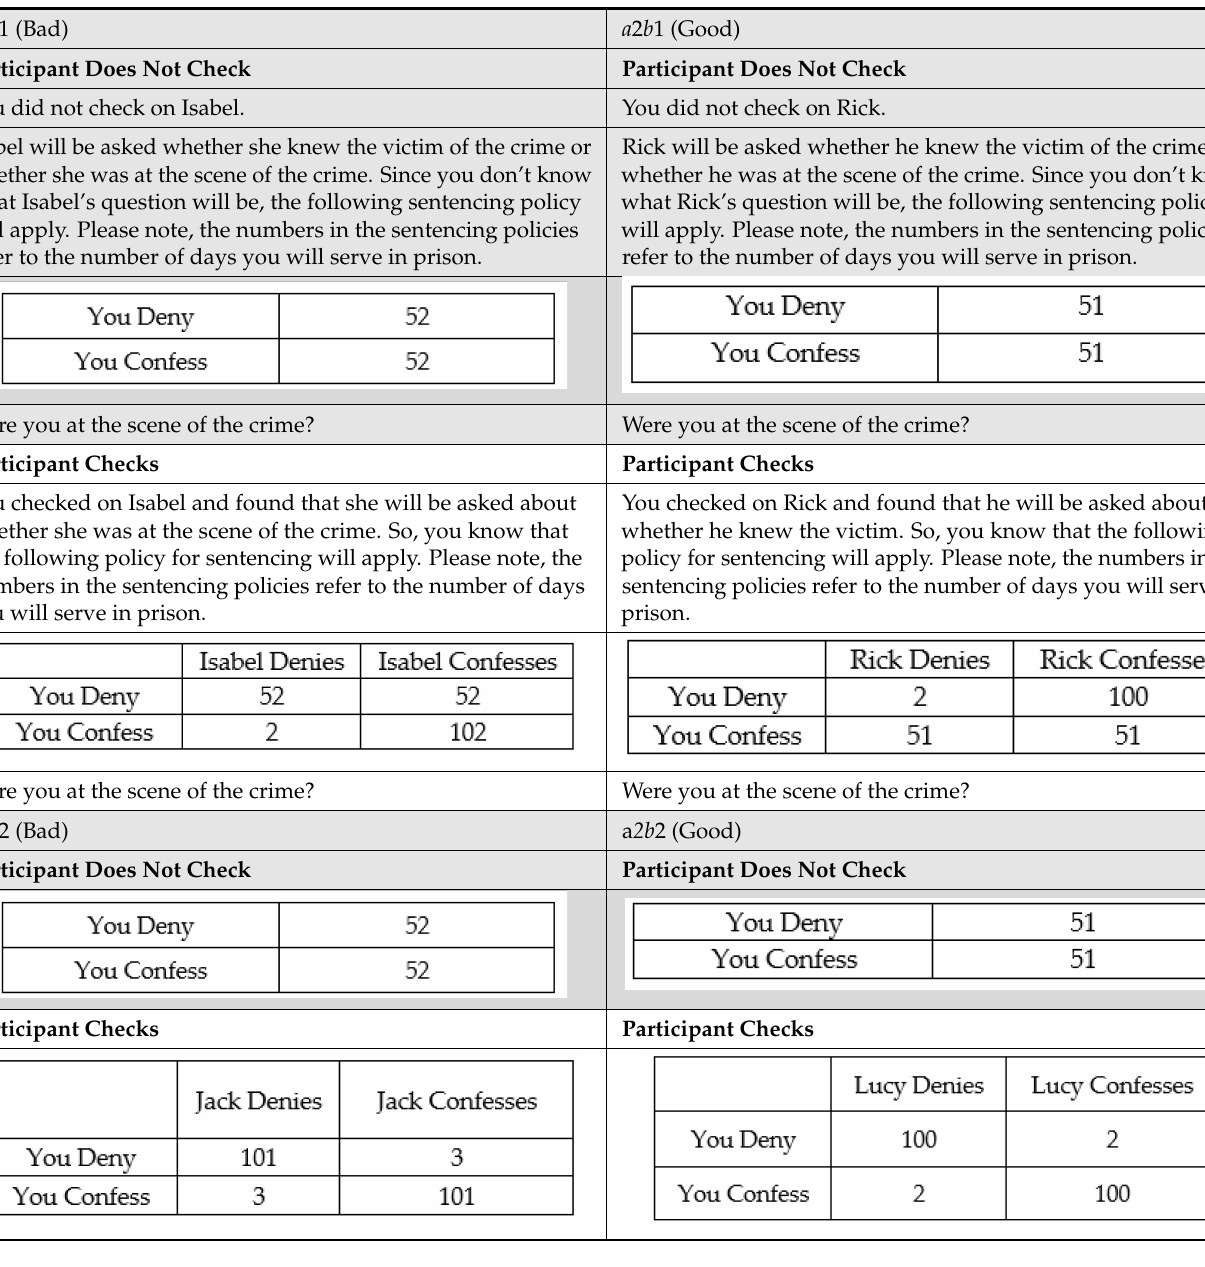
Table 6. The good and bad matrices for the a2b1 and a2b2 trials in Experiment